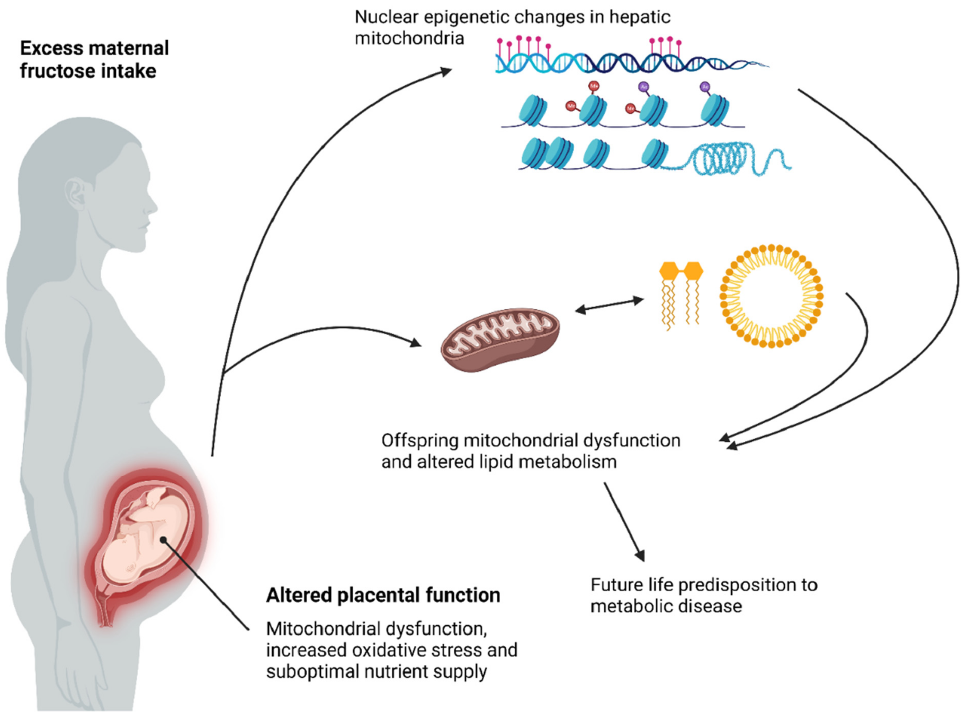
Figure 3. Proposed mechanisms that influence offspring predisposition to metabolic disease fol ‐ lowing excess maternal fructose intake . Proposed mechanisms that influence offspring predispo ‐ sition to metabolic disease. Excess maternal fructose intake may alter maternal mitochondria func ‐ tion, placental mitochondrial function, increased placental oxidative stress and nutrient supply to the foetus during pregnancy. The subsequent foetal in utero environment programmes foetal mito ‐ chondrial dysfunction and lipid metabolism via nuclear epigenetic changes in hepatic mitochondria, increased free fatty acid (FFA) production and mechanisms of lipid metabolism. This results in an asymptomatic underlying genotype, which may result in future life predisposition to metabolic dis ‐ ease. Diagram created with BioRender.com, accessed on 27 September